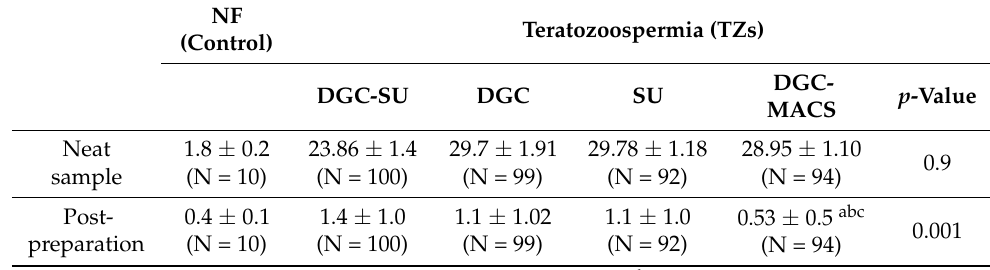
Table 4. ROS (units) (reactive oxygen species) levels in all studied subjects before and after preparation of semen of normal fertile (NF) men (control) and men with teratozoospermia (TZs).